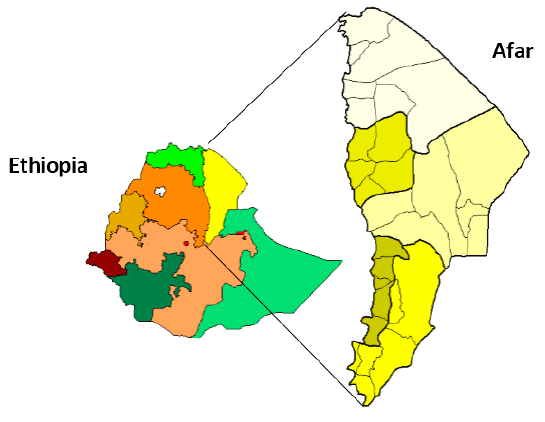
Figure 1. Ethiopia (scale 1:41,000,000) Afar State, zones and woredas (scale 1:9,200,000).